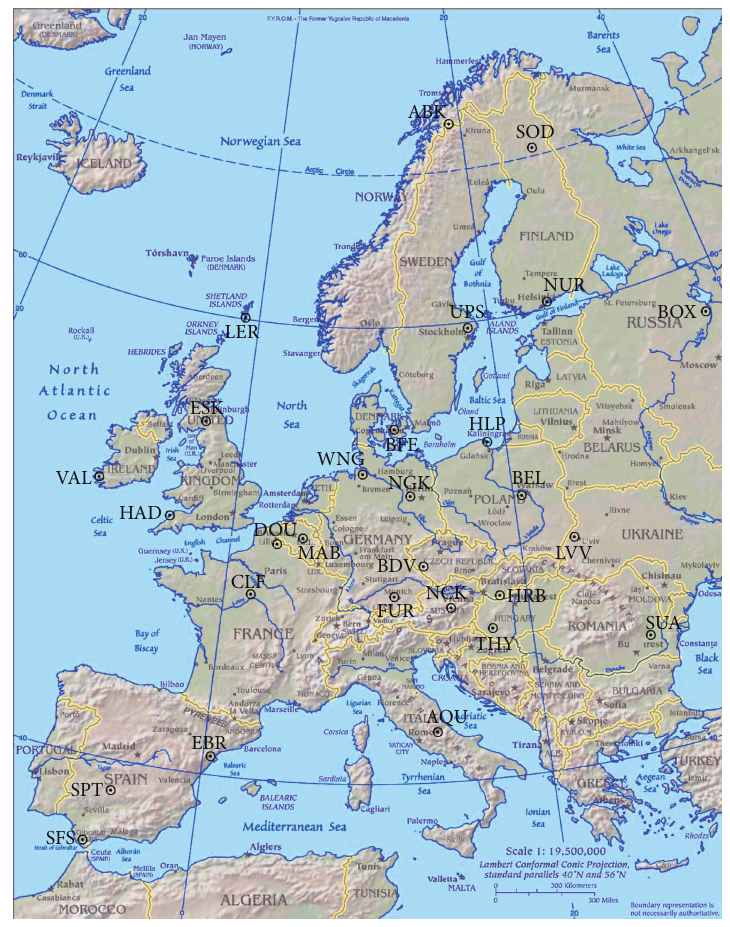
Figure 2: The locations of observatories in